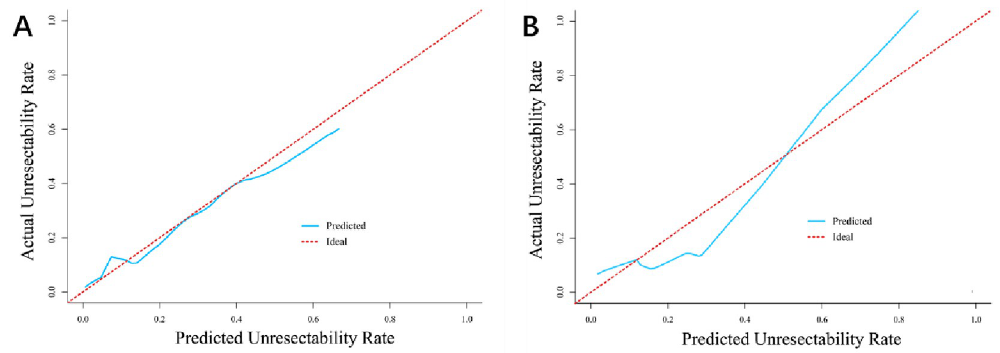
Fig 4. The calibration curve for predicting unresectability rate of training (A) and validation (B) cohort.